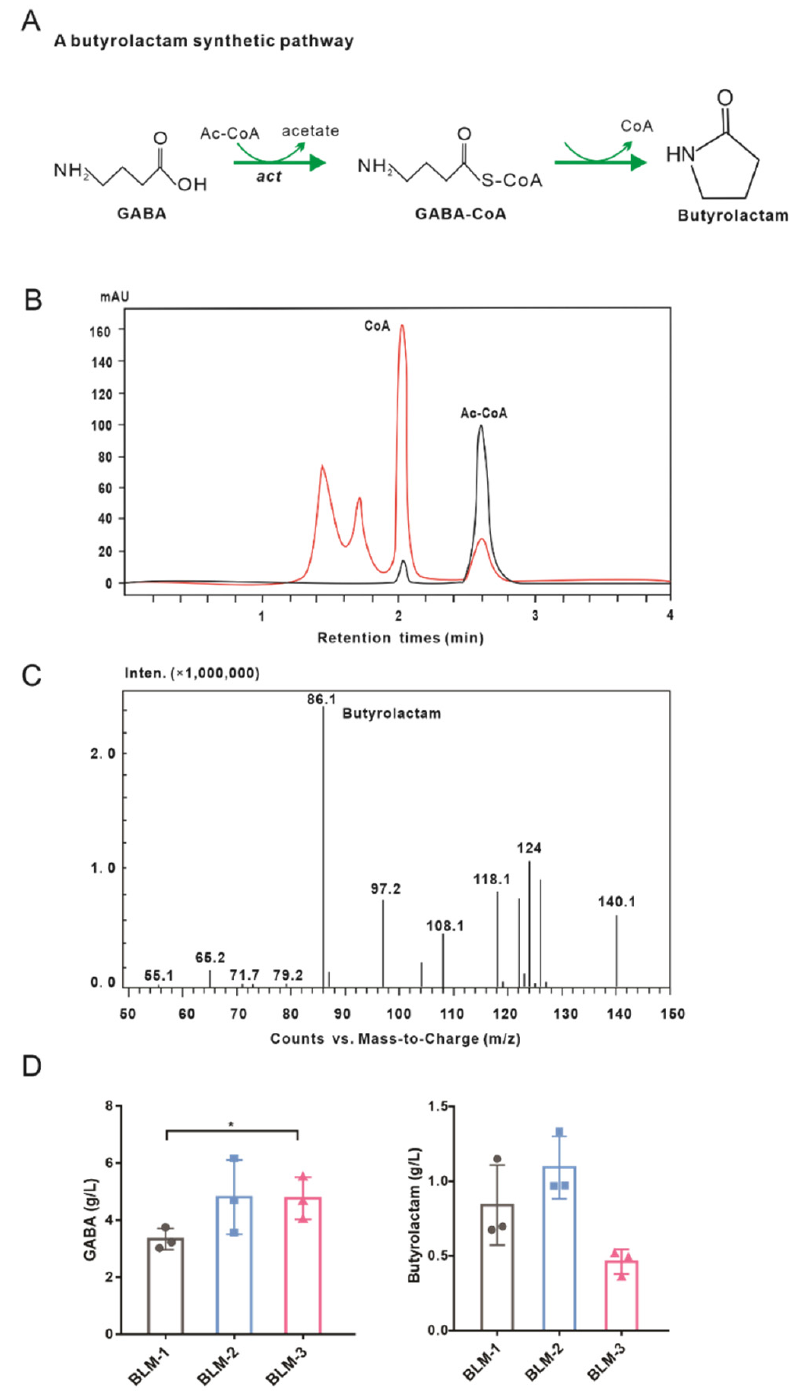
Figure 5. A metabolic pathway for butyrolactam biosynthesis. ( A ) An acetyl-CoA-dependent pathway for butyrolactam biosynthesis from GABA. ( B ) In vitro analysis of Act activity using HPLC. Time profiles of CoA and acetyl-CoA concentrations are shown. Black represents negative control and red represents experimental group assay. ( C ) Analysis of butyrolactam production by the recombinant BLM-1 strain in flask cultivation using HPLC–MS. ( D ) GABA and butyrolactam productions from glucose in the engineered BLM strains. Data shown are mean values from three biological replicates and the standard deviations are presented. Significant differences were determined using Student’s t test (* p < 0.05).